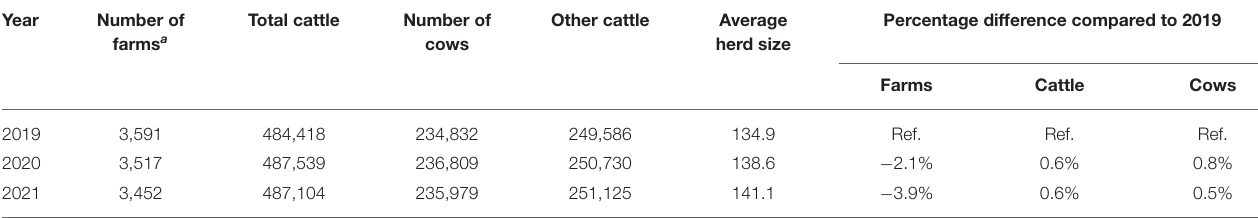
TABLE 1 | Dairy cattle at 31st December. Emilia-Romagna Region